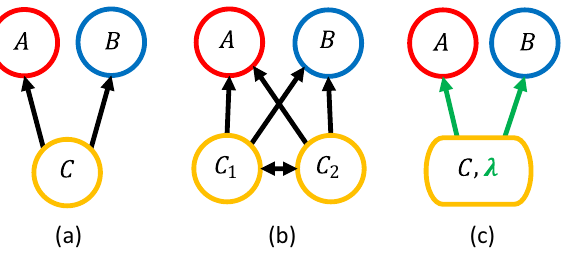
Figure 1. An ecosystem with two predators ( A , B ) and one prey ( C ). ( a ) A homogeneous system where all individuals of a species have the same interaction strength with another species. Arrows represent trophic interaction pointing from prey to predator. ( b ) Heterogeneity is added by splitting the prey into two types ( C 1 , C 2 ), each with their own interaction strengths with the predators. Double-sided arrow represents the exchange of individuals between the prey subpopulations. ( c ) An equivalent description using the total prey population C and the prey type composition (cid:31) . Arrows represent “effective” interaction strengths that depend on (cid:31)